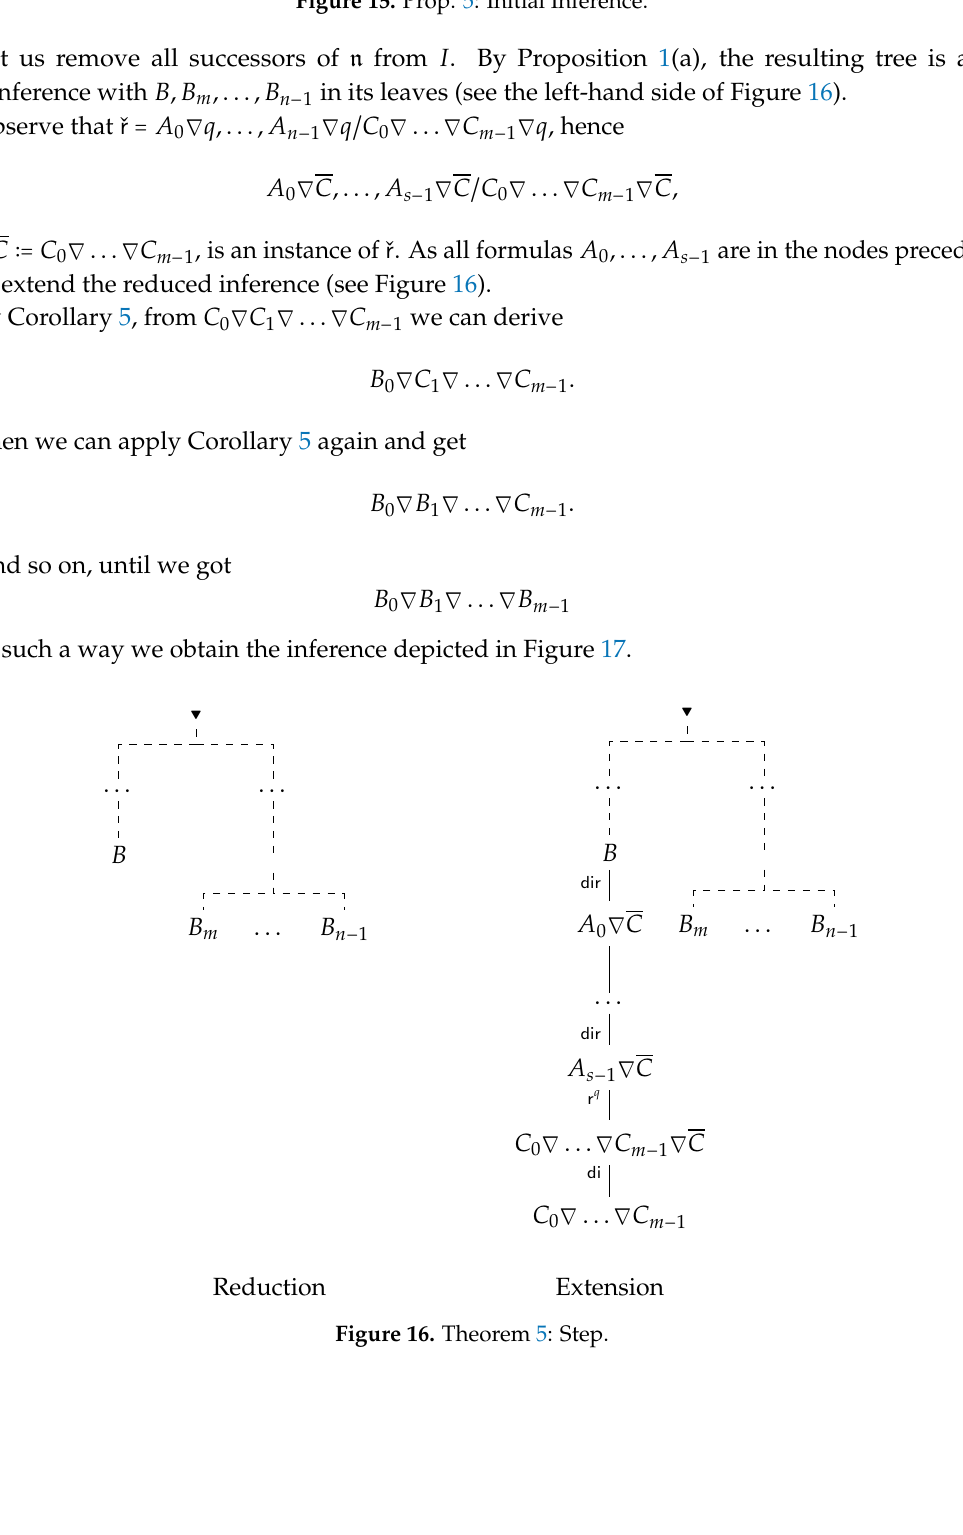
Figure 15. Prop. 5: Initial Inference.